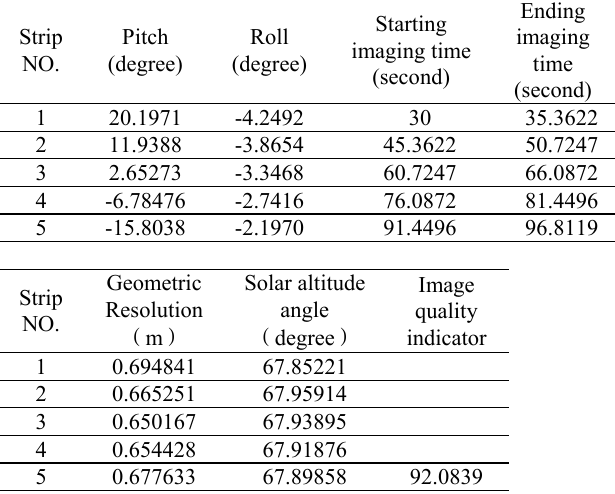
Tab.3 The image-scheduling result of the target